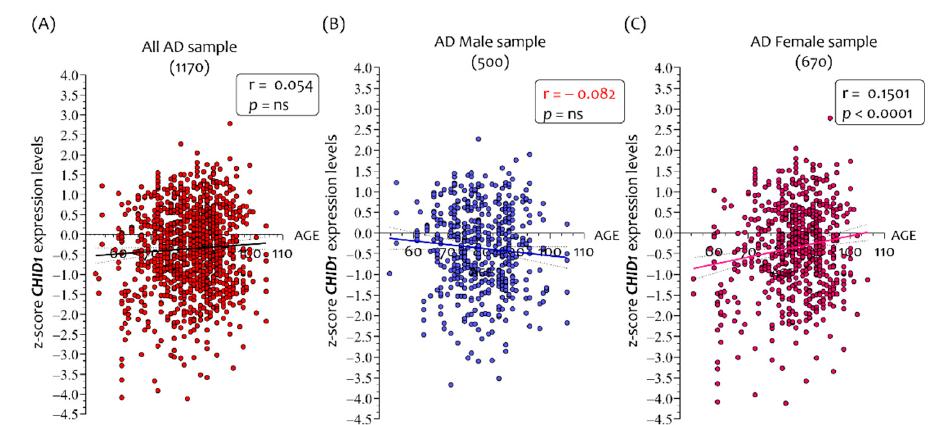
Figure 3. Correlation analysis between CHID1 brain expression levels and the age of AD patients from which the samples were taken. Correlation analysis between CHID1 and the age of AD patients ( A ), sorted according to the sex in brains of 1266 males ( B ) and 587 females ( C ). Data in the figure are indicated as z-score intensity expression levels and presented graphically as dot plots. p values < 0.05 were considered to be statistically significant.